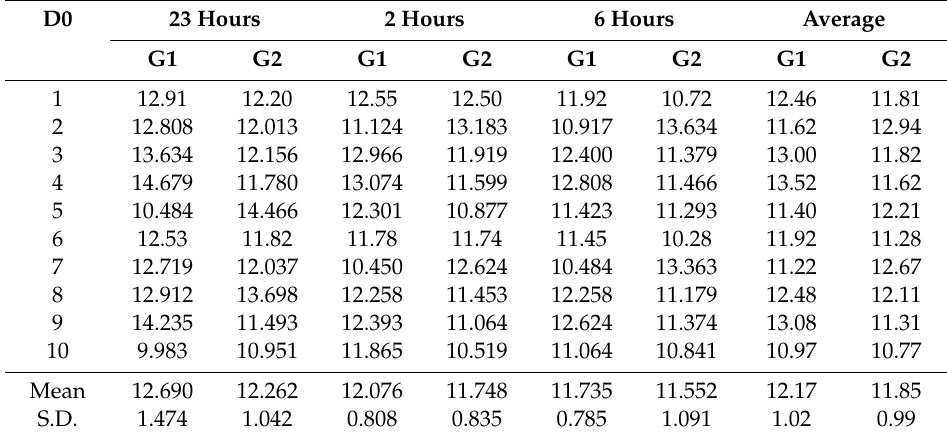
Table 3. Test animal serum 25(OH)D analysis results (D0, unit: ng / mL). D0